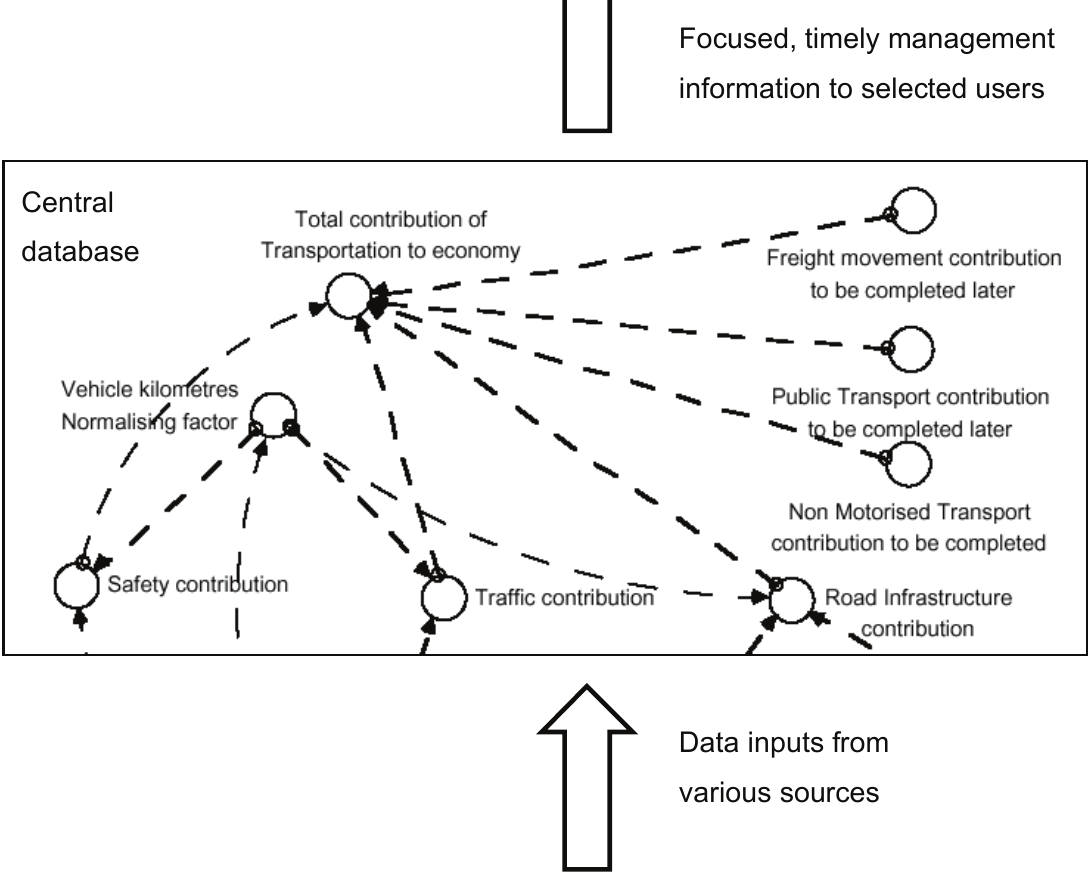
Figure 3: Illustration of a central information base, integrating various information sources and processing this into focused management information